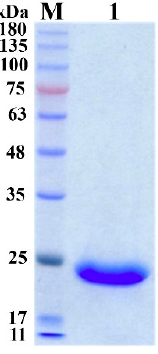
Figure 1. Purification of recombinant porcine interleukin 1- β (pIL-1 β ). The SDS–PAGE gel (15% ( w/v ) acrylamide) was stained with Coomassie blue. Lane 1, pIL-1 β (10 µg); lane M, electrophoretic ( w / v ) acrylamide) was stained with Coomassie blue. Lane 1, pIL-1 β (10 µ g); lane M, electrophoretic molecular mass markers. molecular mass